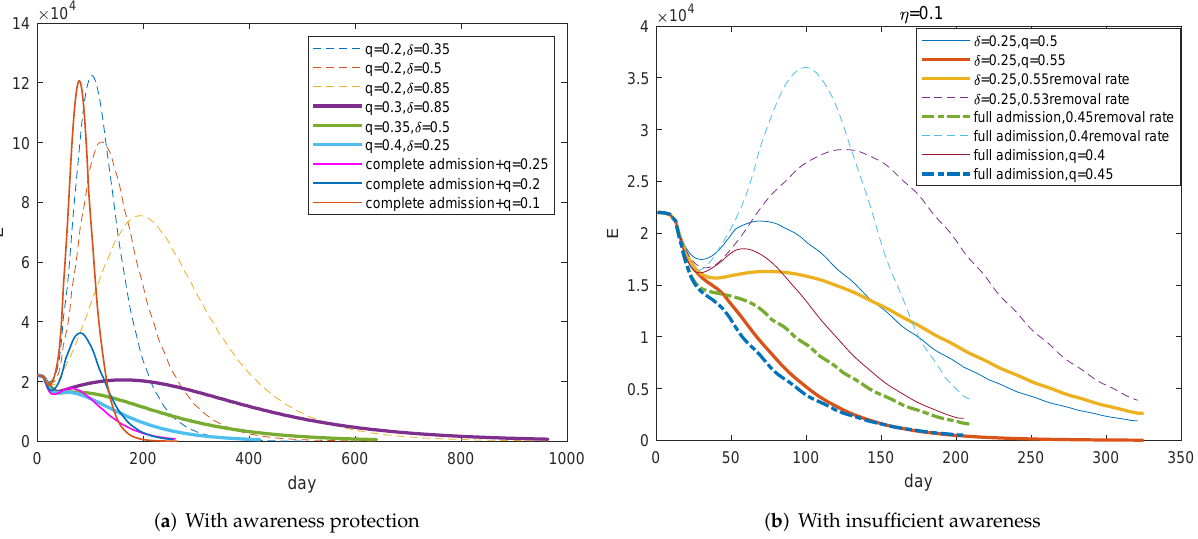
Figure 8. The possibility of maintaining normal social activities. ( a ) With awareness protection, at least 30 percent tracking rate and improved admission rate can play the role of controlling COVID-19 in purpose of maintaining social activities. ( b ) With insufficient awareness protection, a quarter admission rate and at least 55 percent tracking rate can play the the effective control